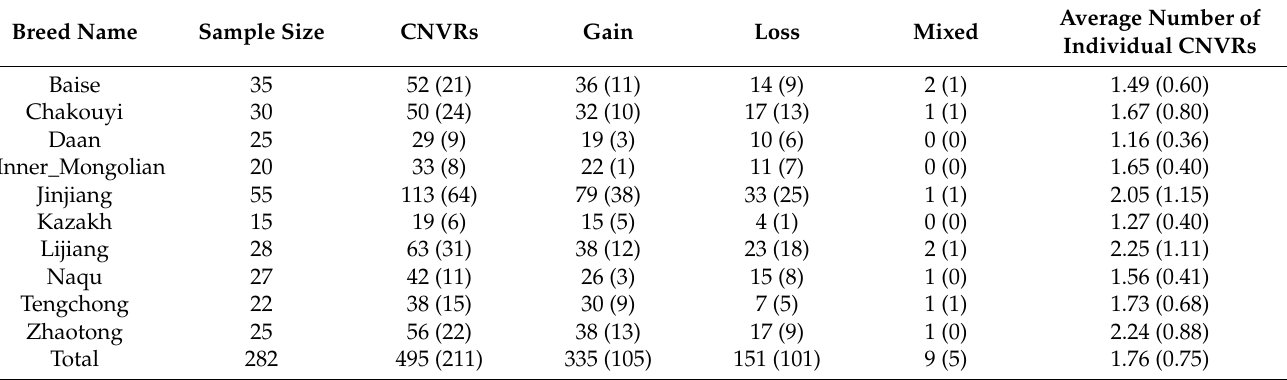
Table 3. Statistical results of CNVR identification